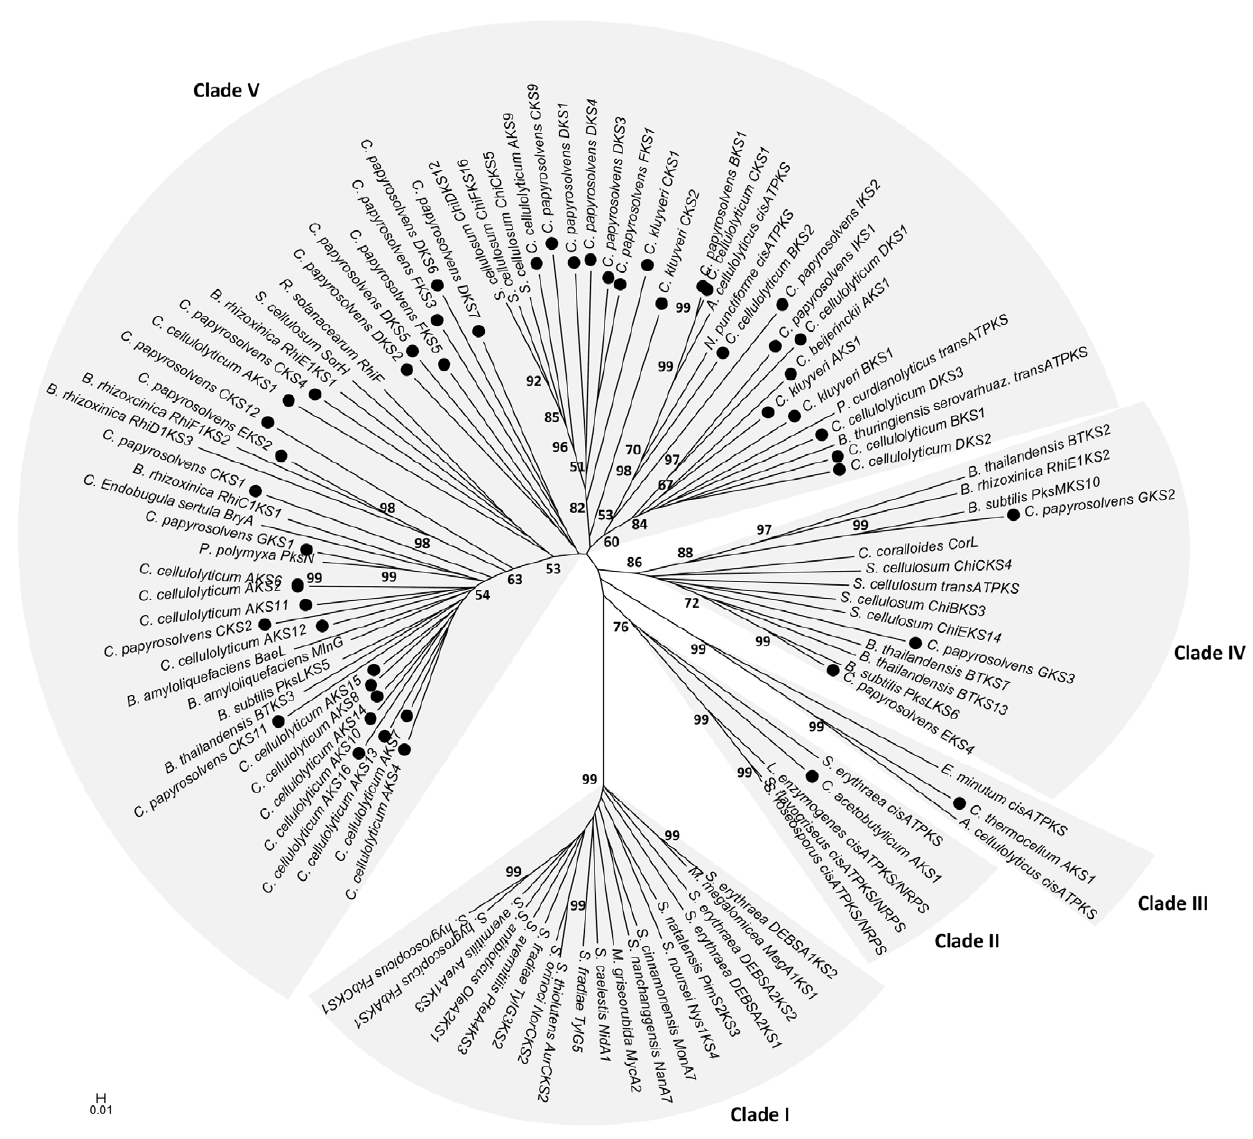
N marks sequences from